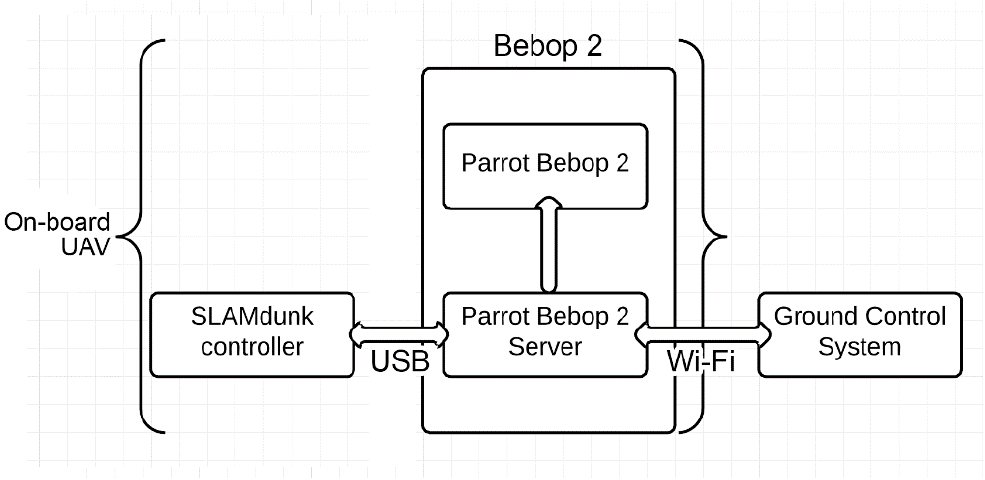
Figure 9. Communication setup between Ground Control, SLAM dunk, and Parrot Bebop 2.